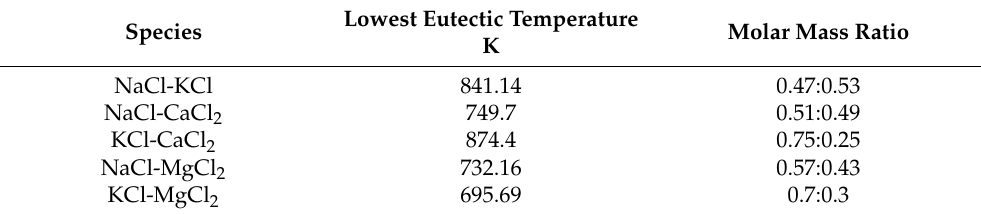
Table 9. Lowest eutectic temperature and molar mass ratio of the binary chloride salts from FactSage.